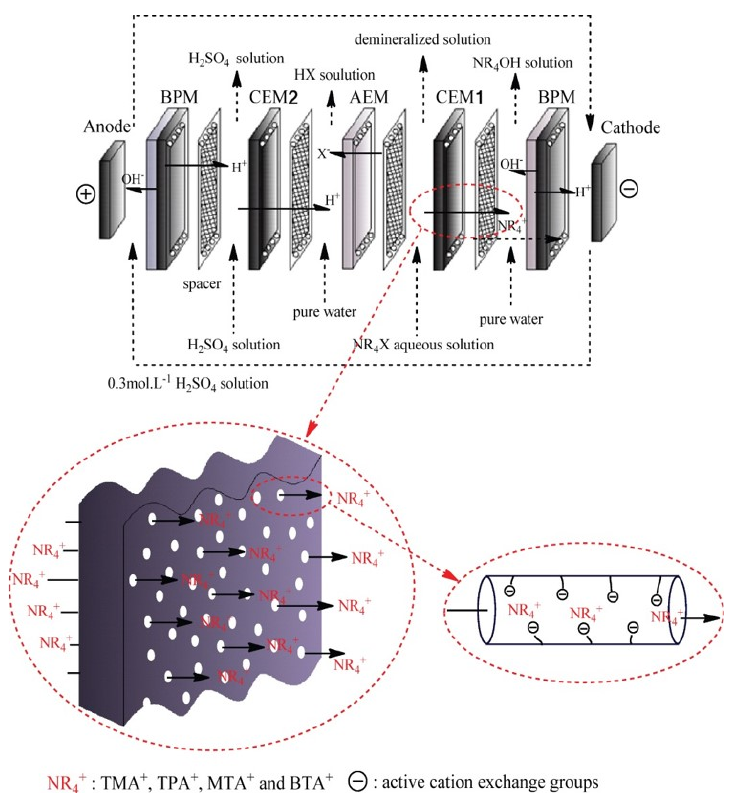
Figure 5. Configuration of the elementary cell for the preparation of NR 4 OH using a four-chamber bipolar membrane electrodialysis system. BPM, bipolar membrane; AEM, anion-exchange membrane; CEM (1,2), cation-exchange membrane; NR 4 X, quaternary ammonium halide (TMACl, TPABr, MTACl, and BTACl) [39].